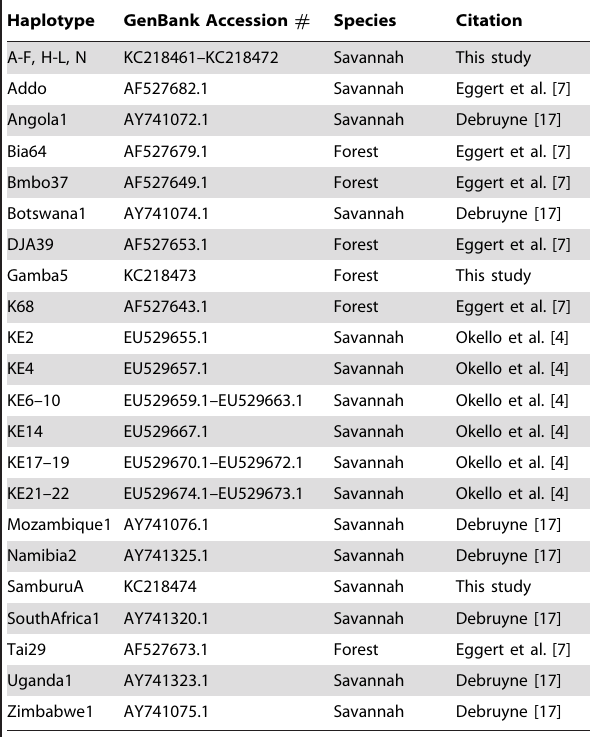
Table 1. GenBank accession number for haplotypes detected in Kenya and Tanzania from this study and published haplotypes used in the neighbour-joining tree.